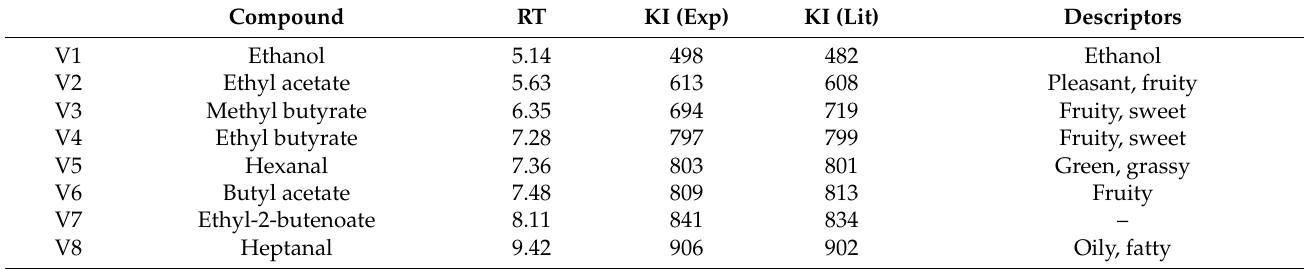
Table 2. Retention indexes (RT), kovats indexes (KI EXP: kovats index experimental, and LIT: